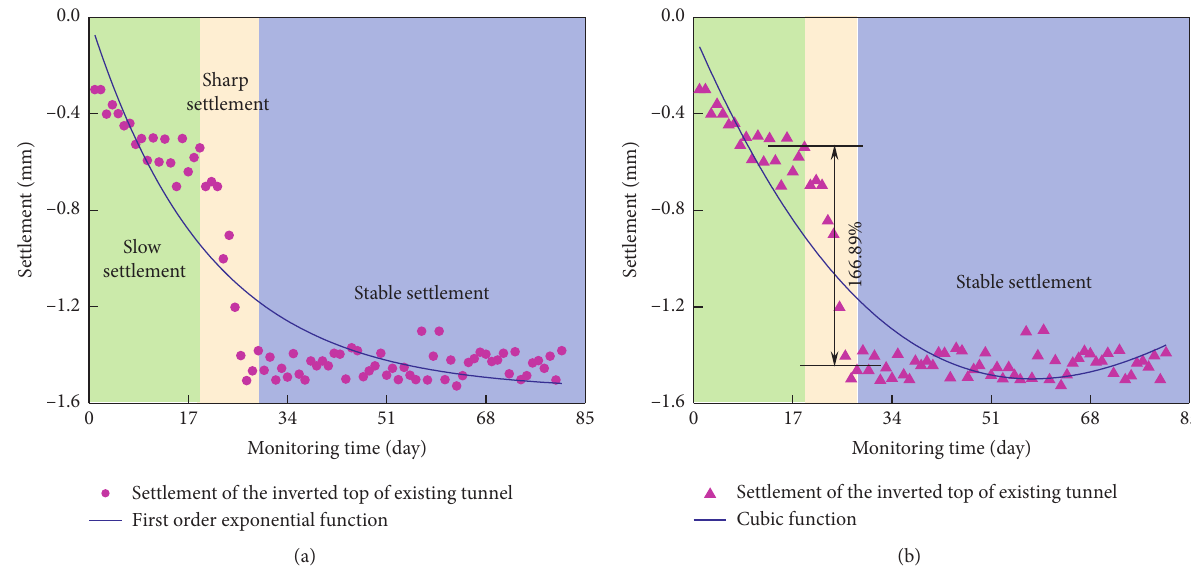
Figure 17: Time-history curves of invert of characteristic DK25 +870 and DK25 +880 sections of the existing tunnel. (a) Section DK25 +870. (b) Section DK25 +880.